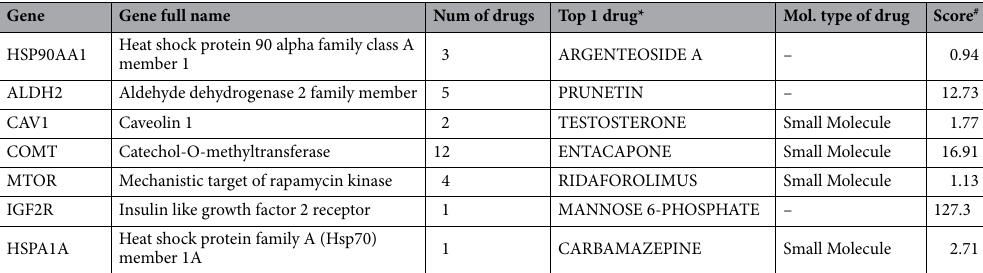
Table 2. Seven genes which were involved in both infections of three coronaviruses and two neurodegenerative diseases, and the drug targeted against these genes. “-”, no data available. “*”, the drug with the top interaction score. “#”, the gene-drug interaction scores provided in the DGIdb database which reflect the confidence and specificity of the gene-drug interactions. The larger, the better. Please see Table S7 for more gene-drug